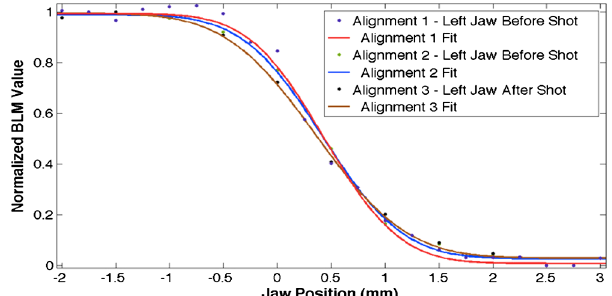
FIG. 10. Beam-based alignment of the left jaw. Alignment 1 and Alignment 2 are performed before Test 1, while Alignment 3 represents the check after Test 1.